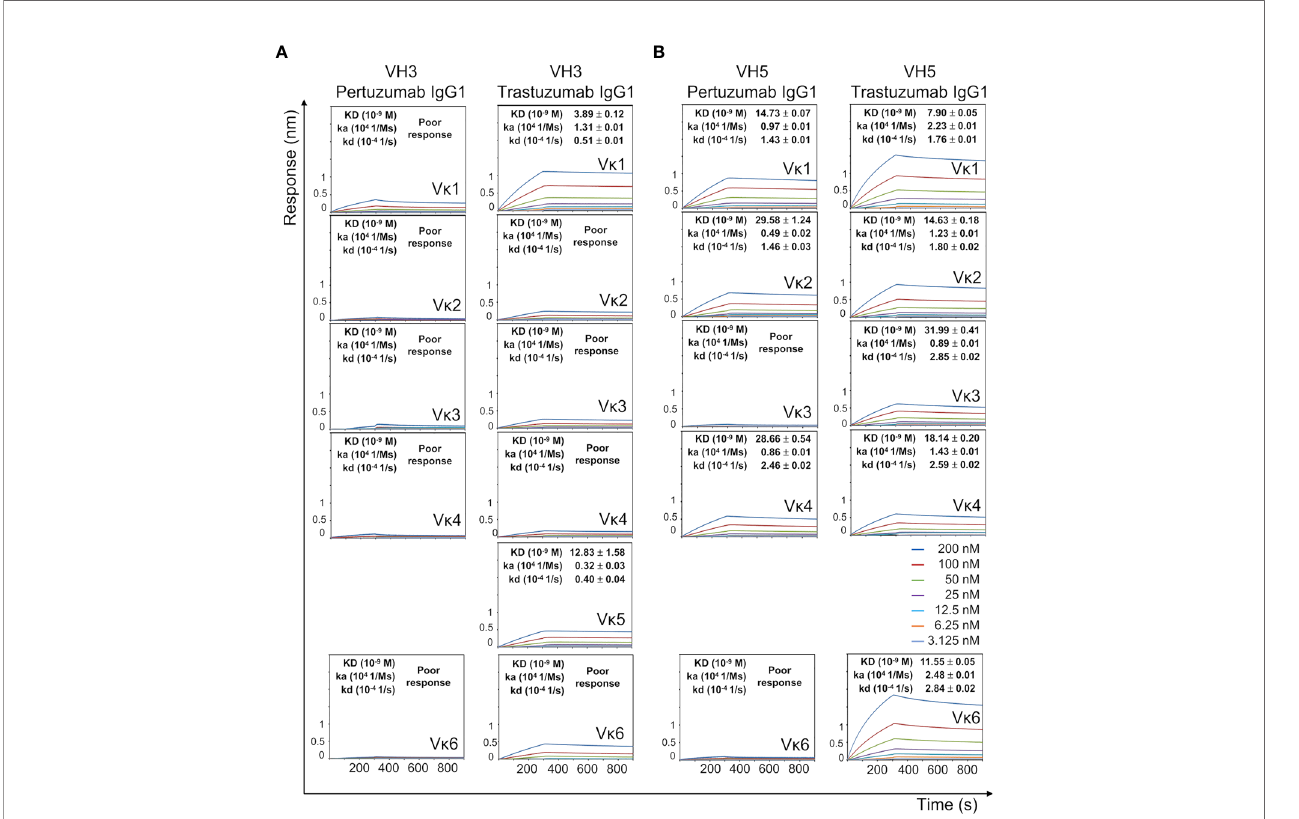
FIGURE 4 | Ni-NTA dissociation equilibrium constants (KD) of Pertuzumab and Trastuzumab VH3 (A) and VH5 (B) IgG1 variants paired with different V k s. The experiments were performed at concentrations from 200 nM to 3.125 nM of the antibodies. Values of KD (M), ka (1/Ms), and kd (1/s) were determined using the Octet RED96 system. The X-axis depicts the time (in seconds) while the Y-axis depicts the binding responses (nm). All the experiments were conducted in at least duplicates. “ Poor response ” re fl ects measurement responses that are less than 0.1 nm for at least three concentrations. Variants that could not be produced are left